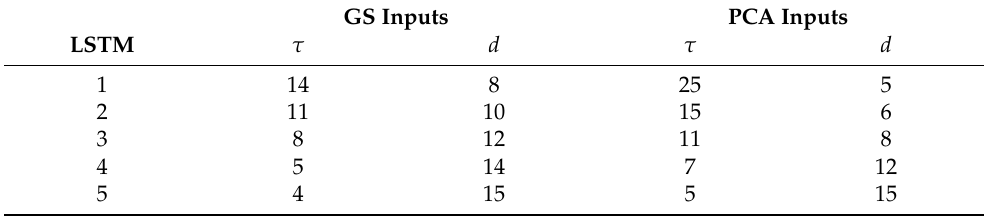
Table 1. Input space hyper-parameters selected using the “GS inputs” and “PCA inputs”